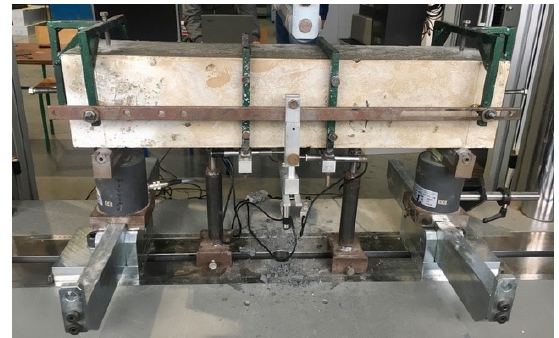
Figure 8. Test stand for determination of the residual tensile strength (3-point bending test).